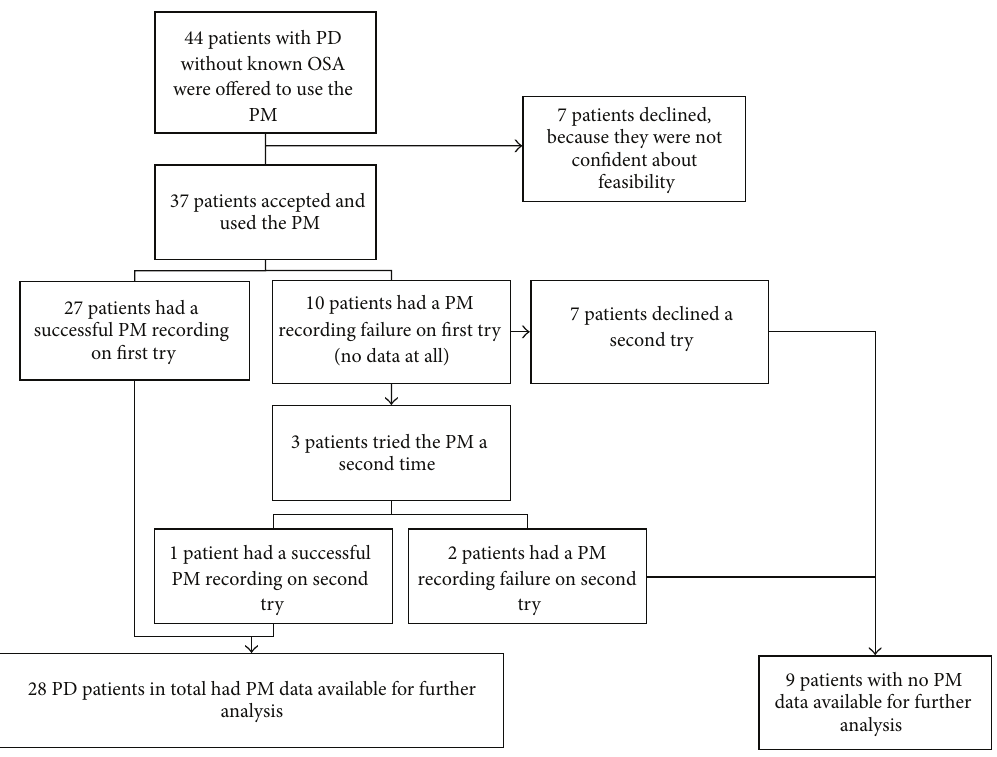
Figure 1: Patients’ recruitment flow